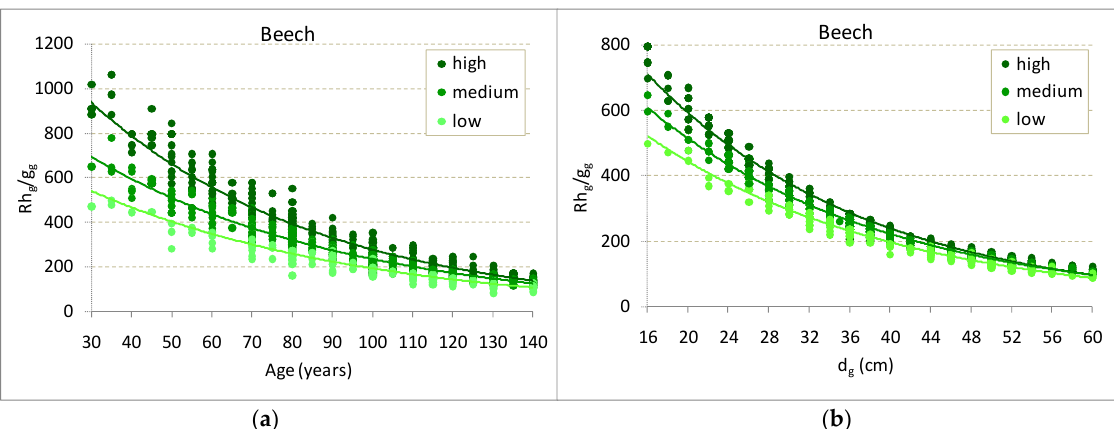
Figure 5. Relationship between Rhg g and age ( a ) and between Rhg g and average diameter ( d g ) ( b ) in beech.